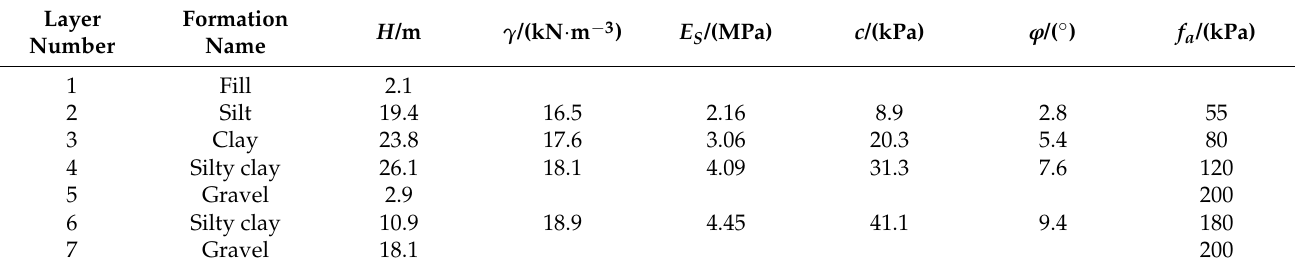
Table 1. Physical and mechanical indexes of soil in the test site.